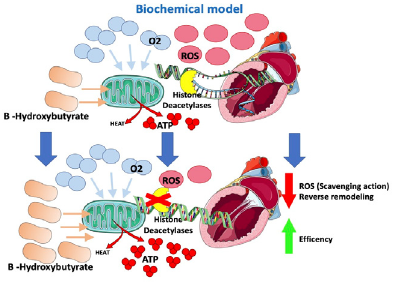
Figure 4. Effects of SGLT2-i on the biochemical